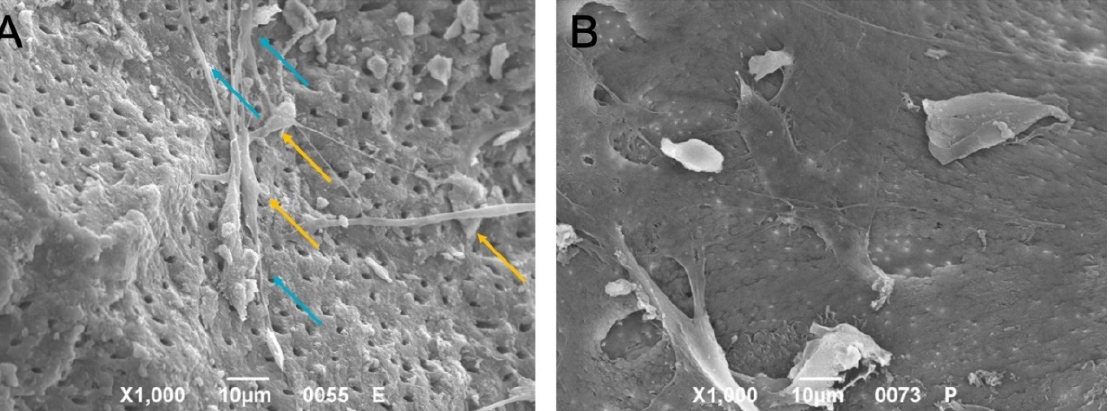
Figure 7. SEM analyses of DPSCs seeded on DP or BG granules ( A and B , respectively). When cells were seeded onto DP, they acquired an odontoblastic phenotype characterized by a short body (or- ange arrows) and an elongated cell process (petrol blue arrow).